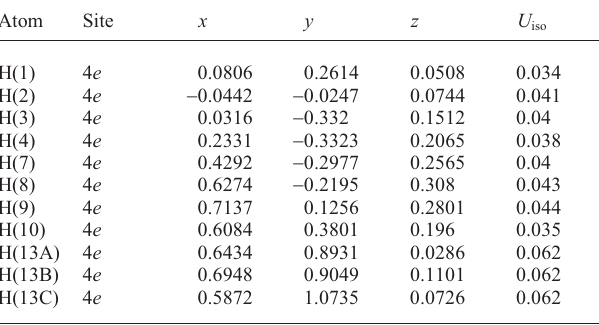
Table 2. Atomic coordinates and displacement parameters (in Å 2 )